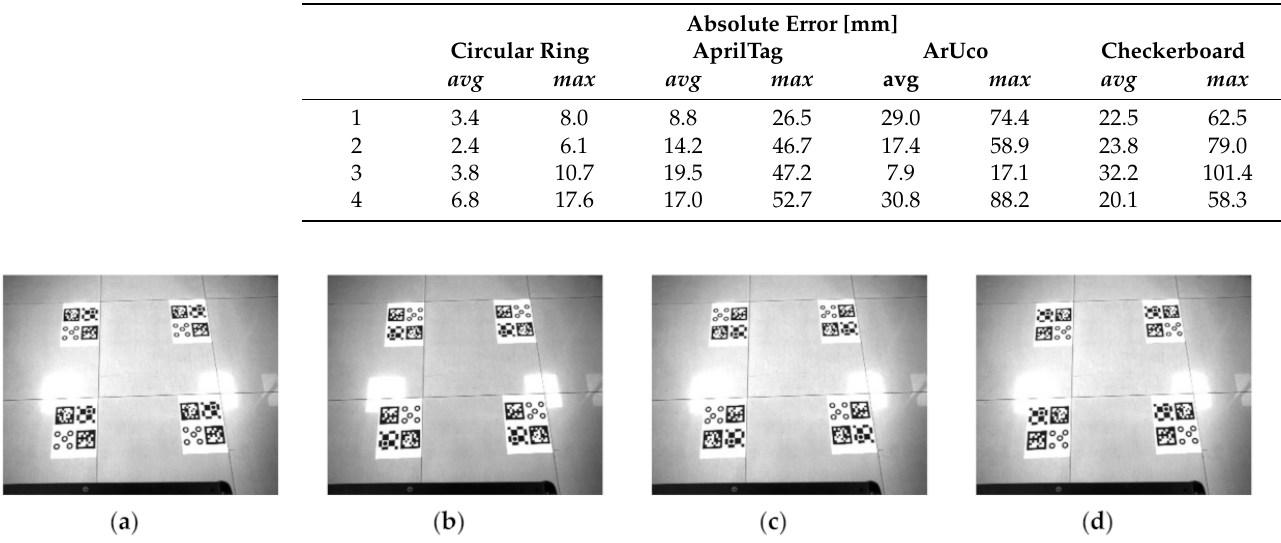
Figure 16. Transform the markers position: ( a ) Position 1; ( b ) Position 2; ( c ) Position 3; ( d ) Position